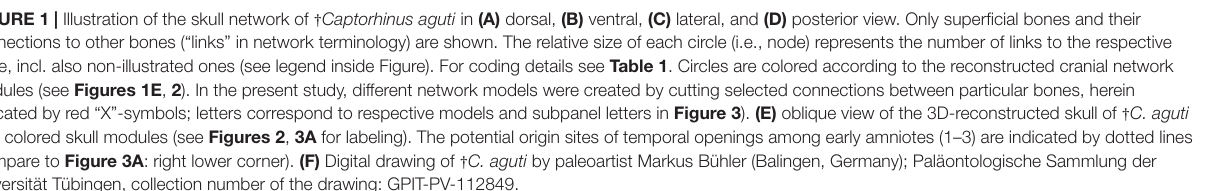
FIGURE 1 | Illustration of the skull network of † Captorhinus aguti in (A) dorsal, (B) ventral, (C) lateral, and (D) posterior view. Only superficial bones and their connections to other bones (“links” in network terminology) are shown. The relative size of each circle (i.e., node) represents the number of links to the respective bone, incl. also non-illustrated ones (see legend inside Figure). For coding details see Table 1 . Circles are colored according to the reconstructed cranial network modules (see Figures 1E , 2 ). In the present study, different network models were created by cutting selected connections between particular bones, herein indicated by red “X”-symbols; letters correspond to respective models and subpanel letters in Figure 3 ). (E) oblique view of the 3D-reconstructed skull of † C. aguti with colored skull modules (see Figures 2 , 3A for labeling). The potential origin sites of temporal openings among early amniotes (1–3) are indicated by dotted lines (compare to Figure 3A : right lower corner). (F) Digital drawing of † C. aguti by paleoartist Markus Bühler (Balingen, Germany); Paläontologische Sammlung der Universität Tübingen, collection number of the drawing: